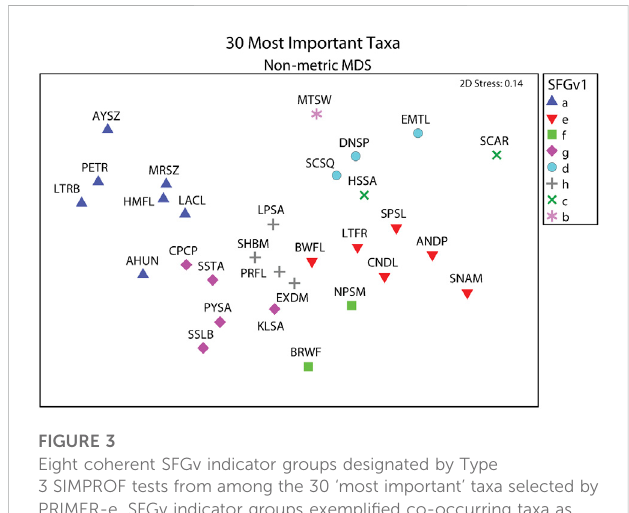
FIGURE 3 Eight coherent SFGv indicator groups designated by Type 3 SIMPROF tests from among the 30 ‘ most important ’ taxa selected by PRIMER-e. SFGv indicator groups exempli fi ed co-occurring taxa as illustratedbytheir assigned symbolsand relativepositions within2- D nMDS space. Letters in legend correspond to SFGv group identities. Speci fi c taxa for taxon codes presented in Table